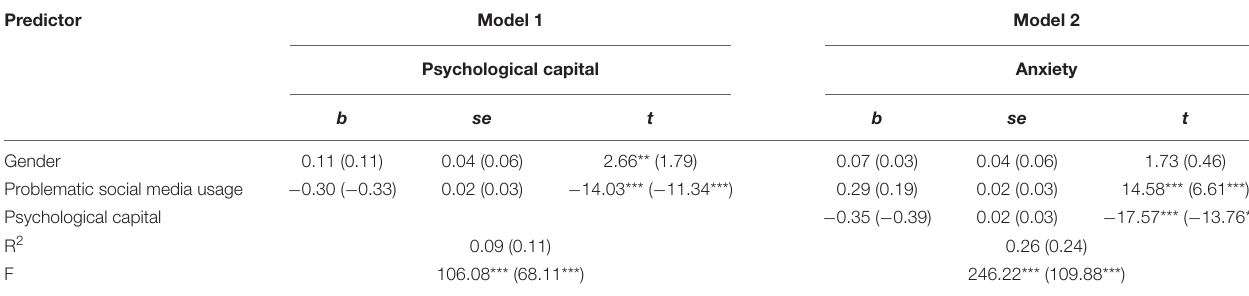
TABLE 2 | Testing the mediation effect of psychological capital.